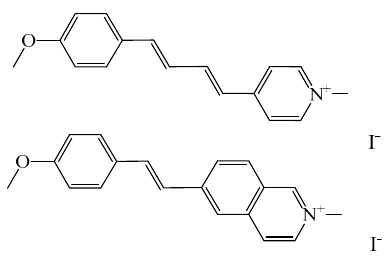
Figure 15. Molecular structures with prolonged conjugate chains.